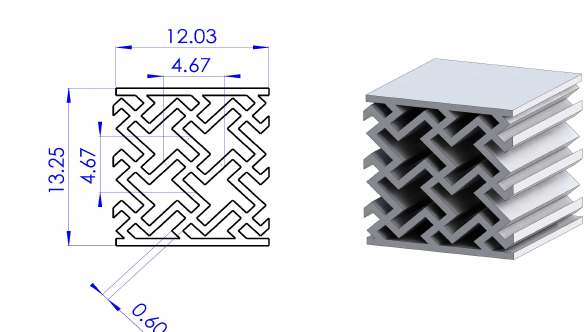
Figure 3. 2D missing-rib auxetic structure the AM250 system (Renishaw, UK) by sintering the 316L-0407 powdered austenitic steel [4]. Structure with missing-rib unit-cell geometry (i.e. 2D missing-